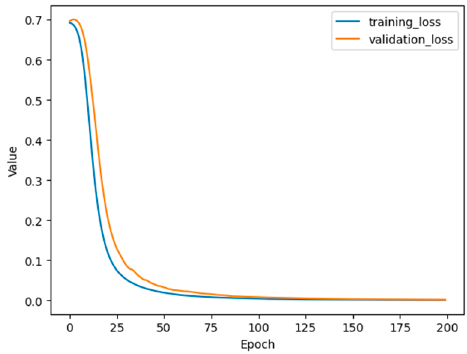
Figure 8. Training and validation loss curves for the ANN model.